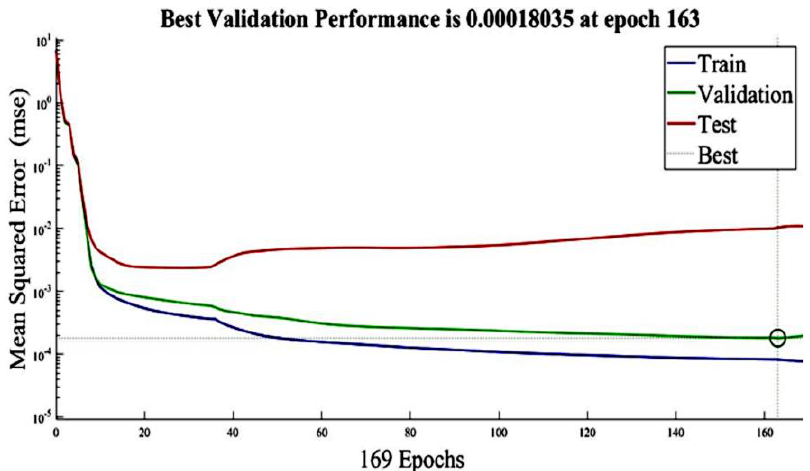
Figure 10. Performance chart of developed MLP.